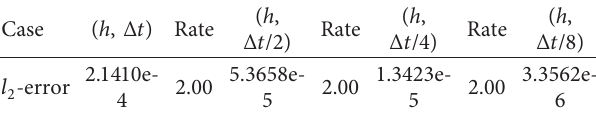
Table 7: Convergence test results of the CN method for time step.